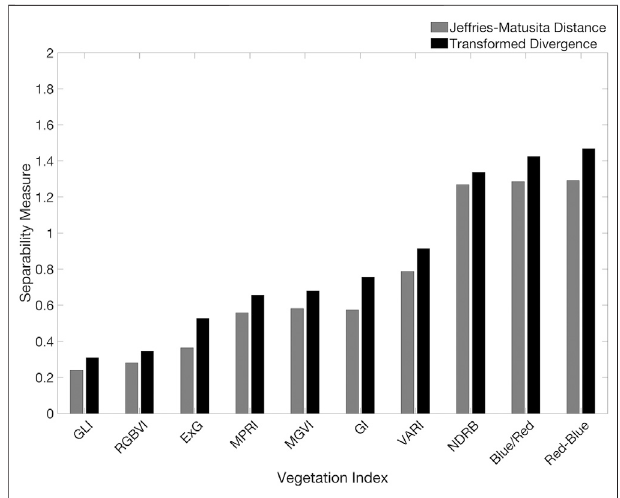
FIGURE 6 | JM and TD values for the 10 RGB vegetation indices, with 0 being no separability between classes and 2 being complete separability.